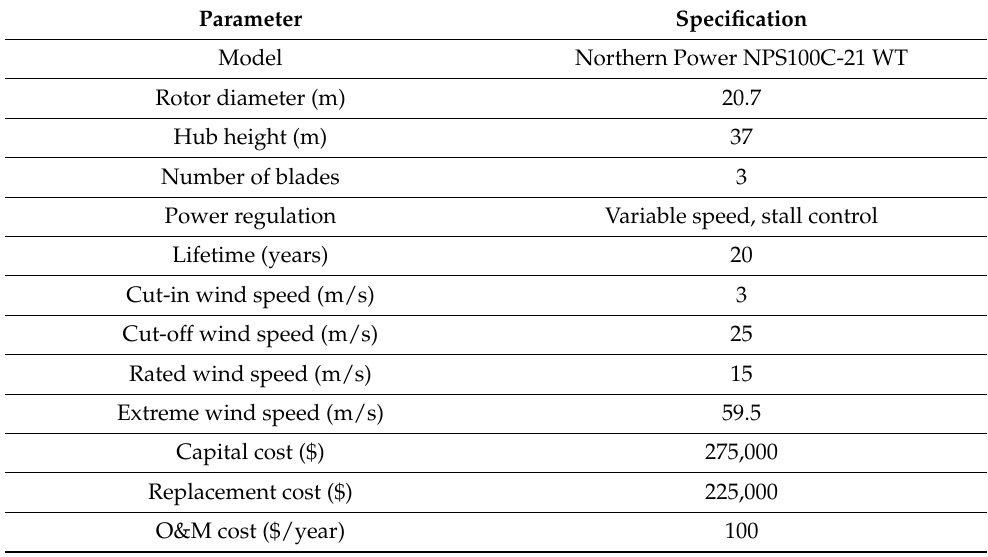
Table 3. Specification data of wind